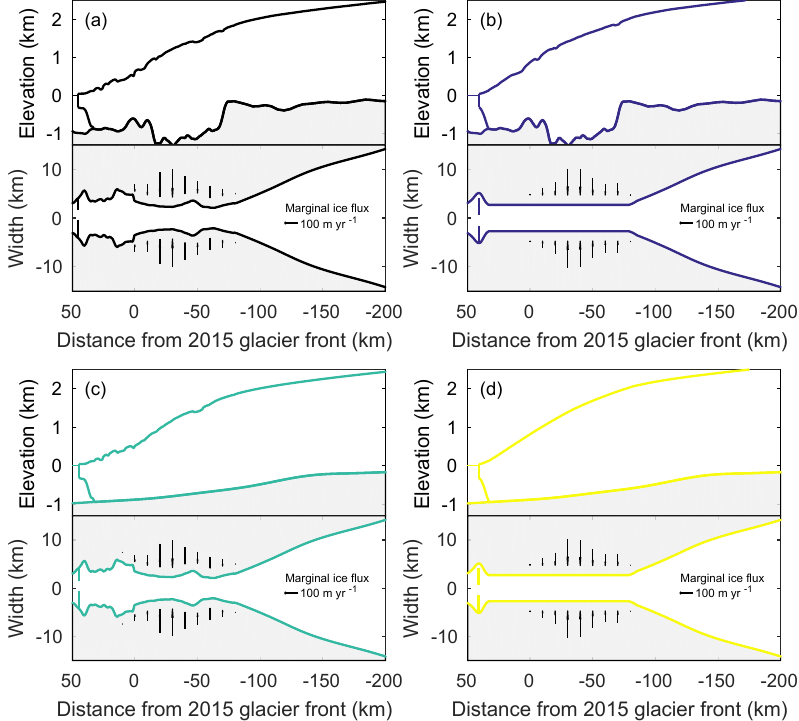
Figure 3. Different model geometries used to investigate the impact of topography on ice dynamics. (a) Original geometry, (b) straight width, (c) straight bed, and (d) straight width and bed. Arrows indicate the tributary ice flux, with their length representative for the influx volume.